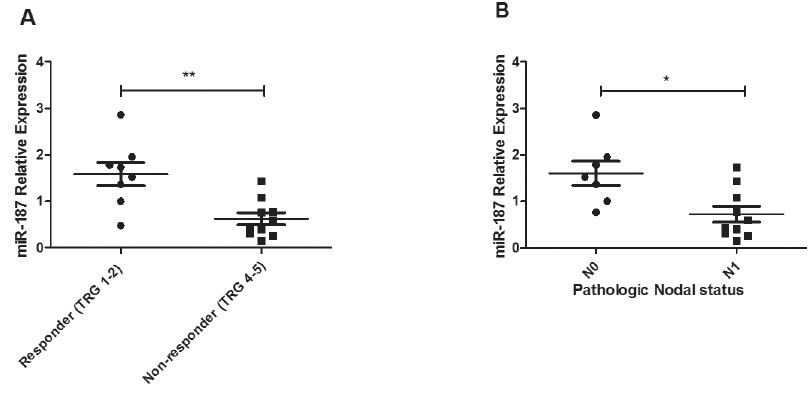
Figure 1. MiR-187 is lower in EAC tumors from nonresponders and patients with lymph node positivity. (A) MiR-187 expression was assessed in pretreatment diagnostic tumor biopsies from EAC patients ( n = 18) by qPCR. MiR-187 expression was significantly lower in nonresponder patients (TRG 4 and 5) when compared with responders (TRG 1 and 2). Statistical analysis was performed using an unpaired, two-tailed Student t test, ** p < 0.01. (B) MiR-187 was significantly lower in patients who were pathologically lymph node pos- itive (N1) when compared with patients who were lymph node negative (N0). Statistical analysis was performed using a Mann–Whitney U test, * p <